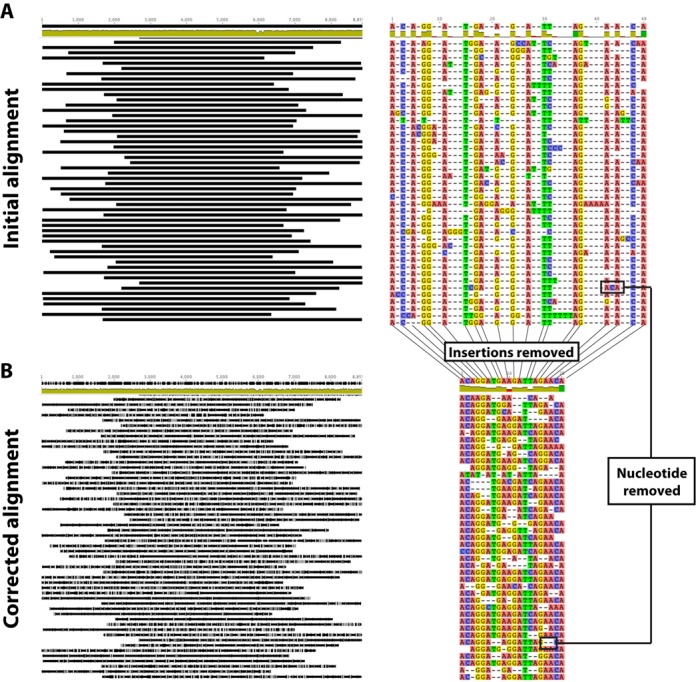
Schematic view of the ‘alignment correction’ procedure implemented during the analytical approach. During implementation of the algorithm, the original alignment (A) obtained using Quiver is edited and the positions most likely to lead to errors in the alignment process due to erroneous technique-driven insertions are removed, generating a corrected alignment (B) that has lost information but which is enriched in the most reliable segments of the reads.